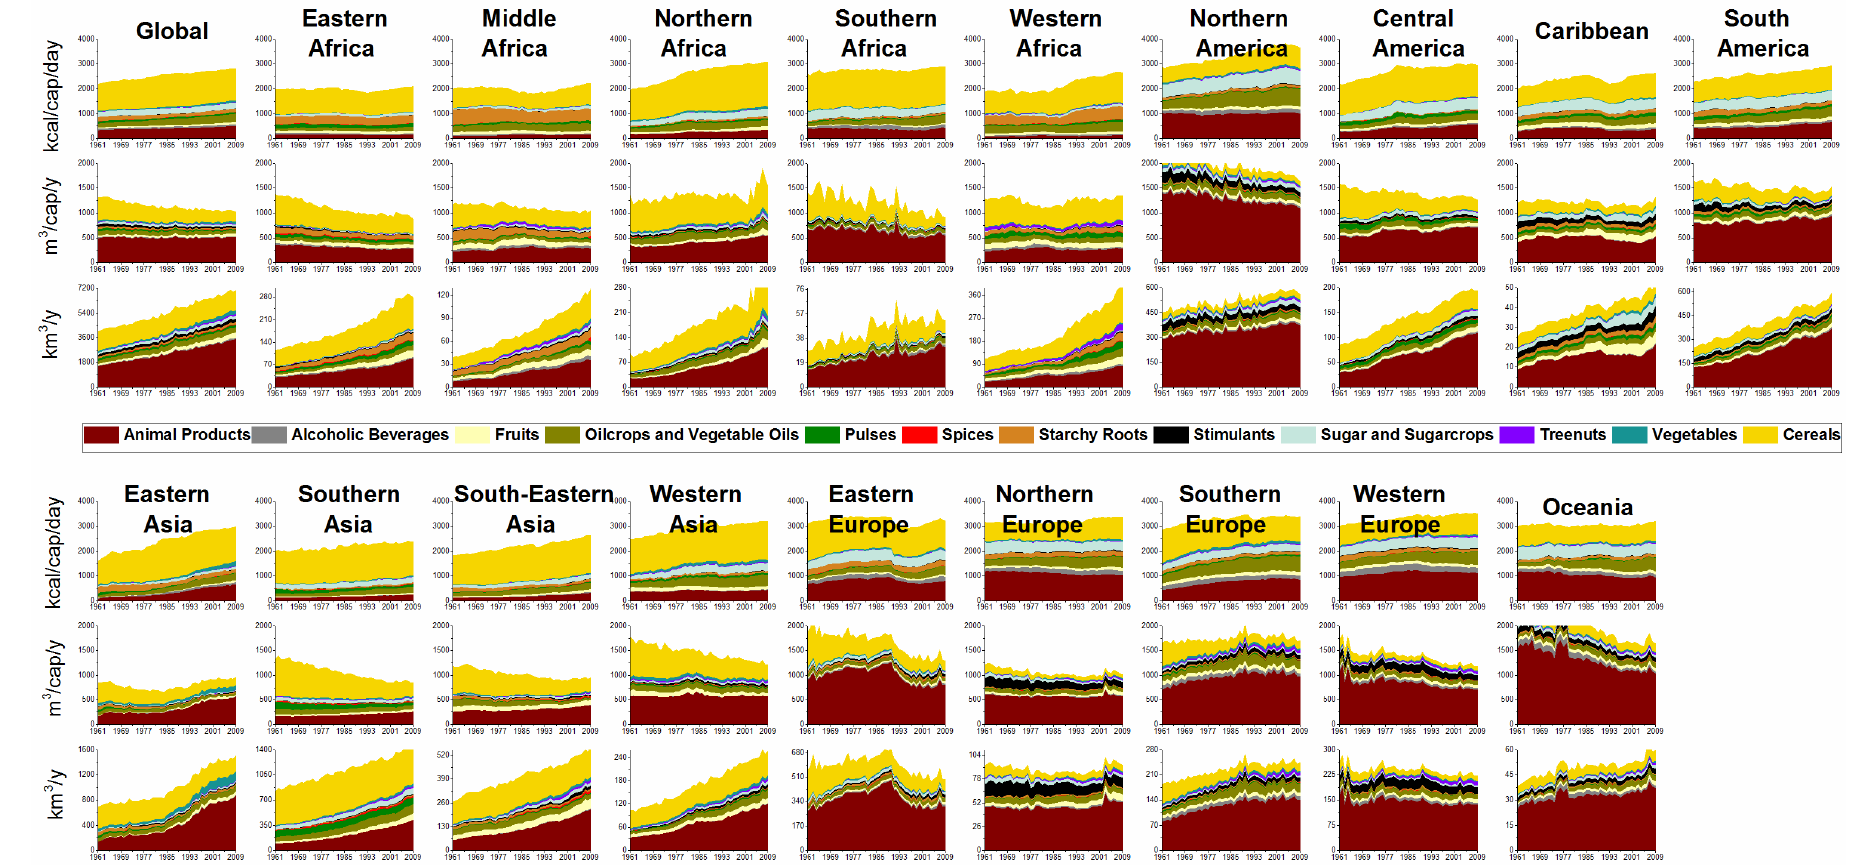
Figure 2. Global Changes in food supply and WF ( middle , m 3 /capita/y) and total WF food